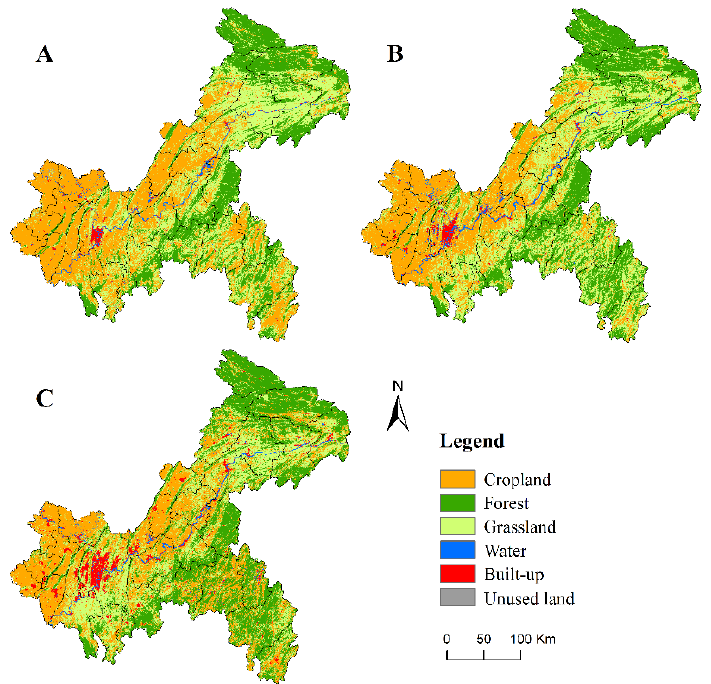
Figure A2. Land use map of Chongqing for ( A ) 2001, ( B ) 2010, and ( C ) 2020.